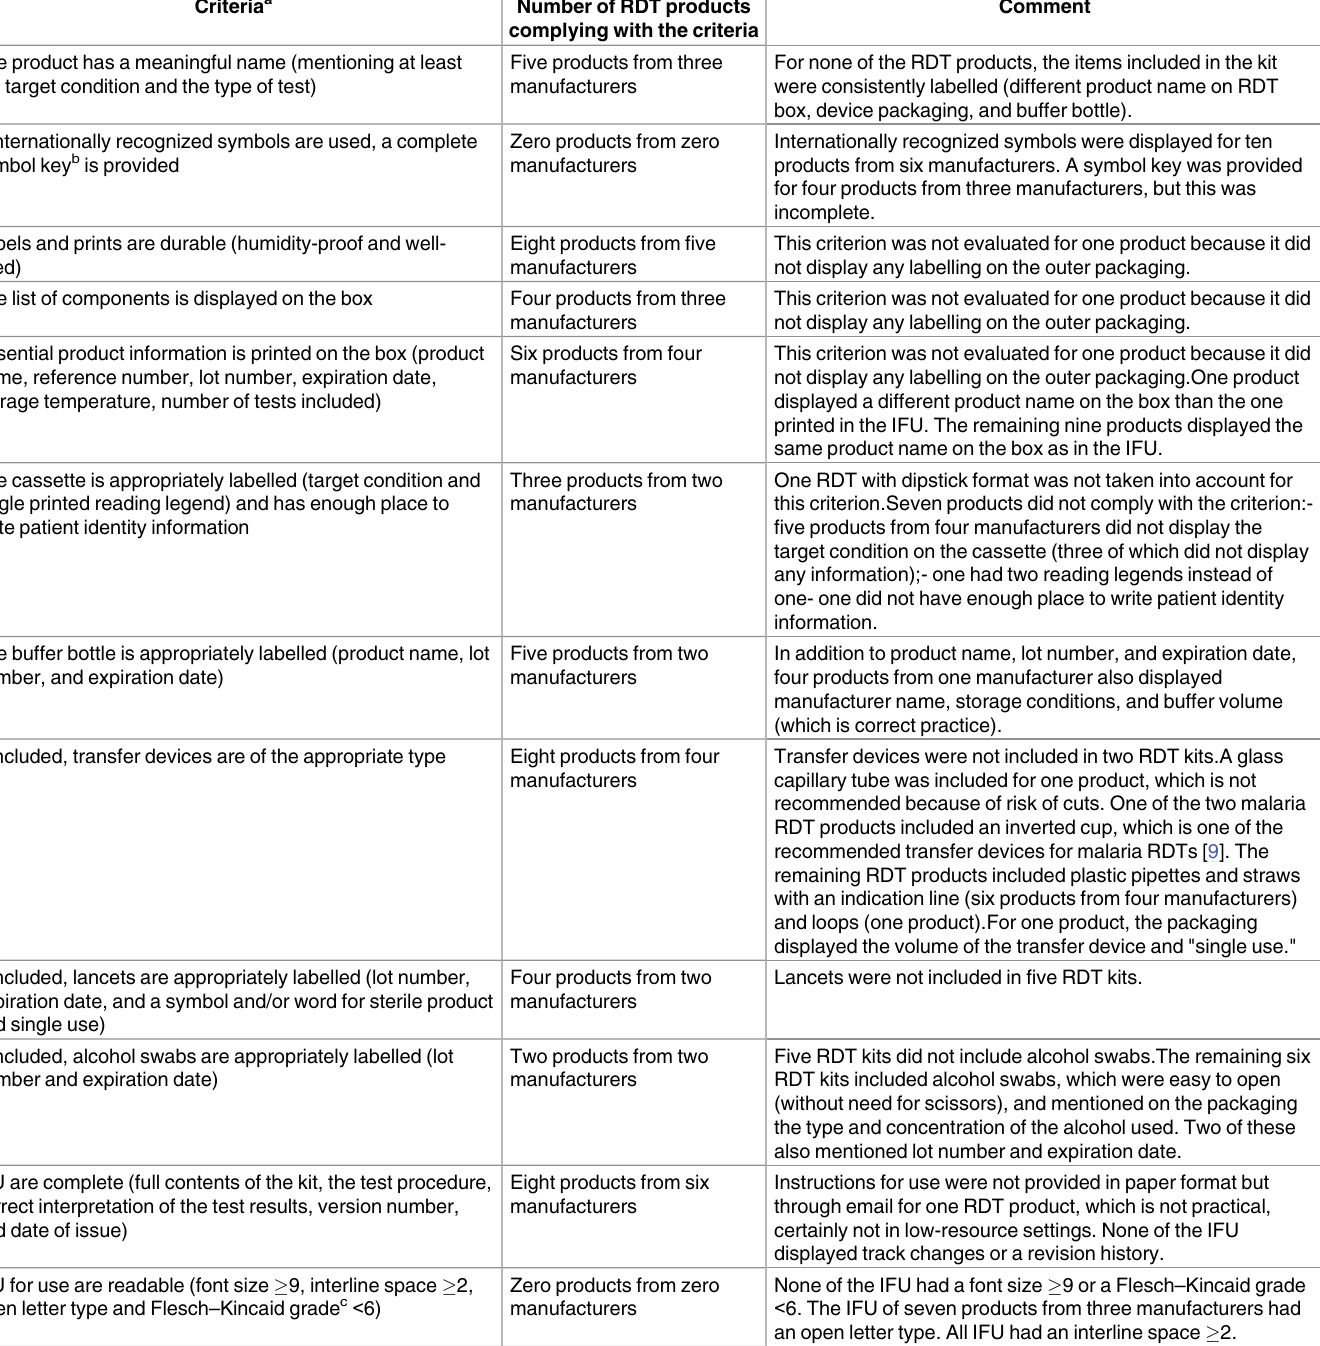
Table 2. Assessment of labelling and instructions for use of 11 rapid diagnostic tests used in the NIDIAG persistent fever